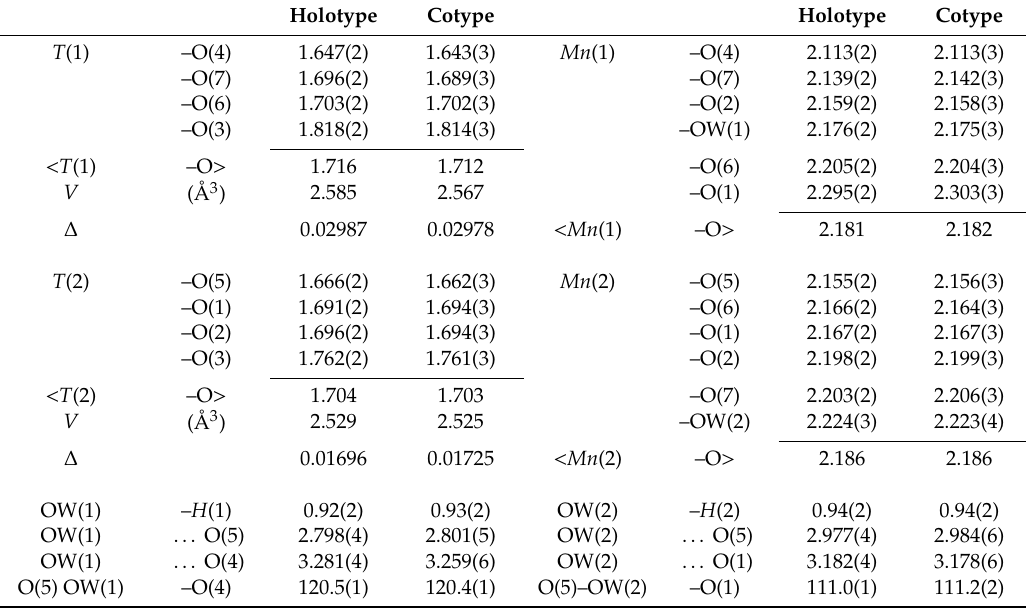
Table 5. Selected Interatomic Distances (Å) and Geometrical Parameters for the Rüdlingerite Fianel (Holotype) and Valletta (Cotype) Specimens.